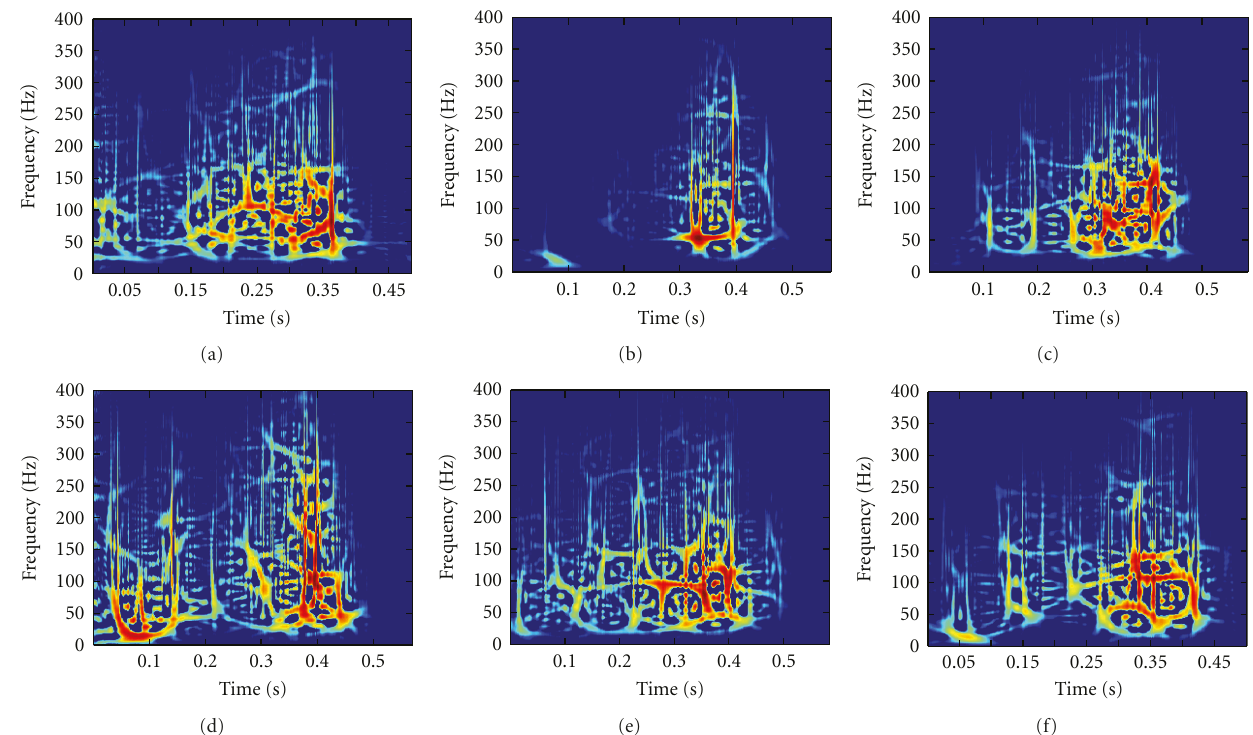
Figure 6: Individual muscle activation time-frequency visualizations of (a) S 1 , (b) S 2 , (c) S 3 , (d) S 4 , (e) S 5 , and (f) S 6 from 001 walk 4.